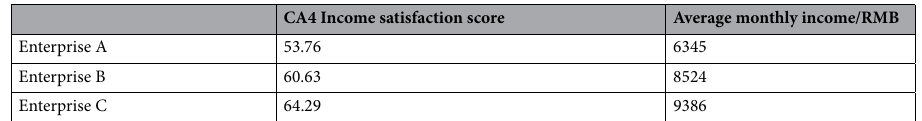
Table 13. Comparison of the safety state score (subsystem C) of front-line workers and the average monthly income of coal miners in three